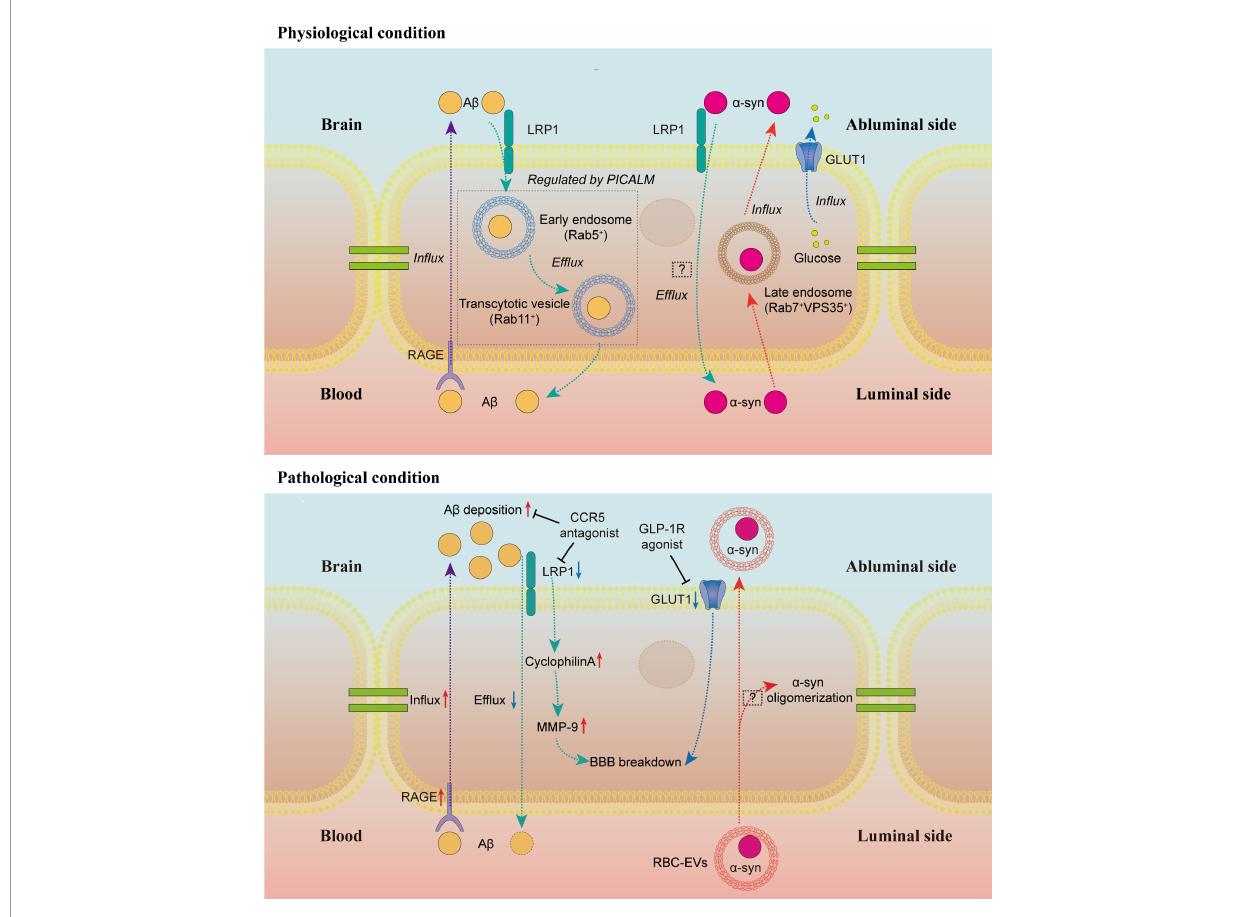
FIGURE1 Brain endothelial cell transport in physiological and pathological conditions. Under physiological conditions, RAGE regulates the influx of A β to the brain, while LRP1 mediates the efflux of A β . The LRP1-dependent transendothelial A β transport is regulated by PICALM. PICALM guides A β to Rab5-positive early endosome and Rab11-positive transcytotic vesicle to the luminal side of BECs. The α -syn efflux is also an LRP1-dependent process, but the underlying mechanisms are still unclear. In the luminal-abluminal direction, the α -syn trafficking across BECs is directed